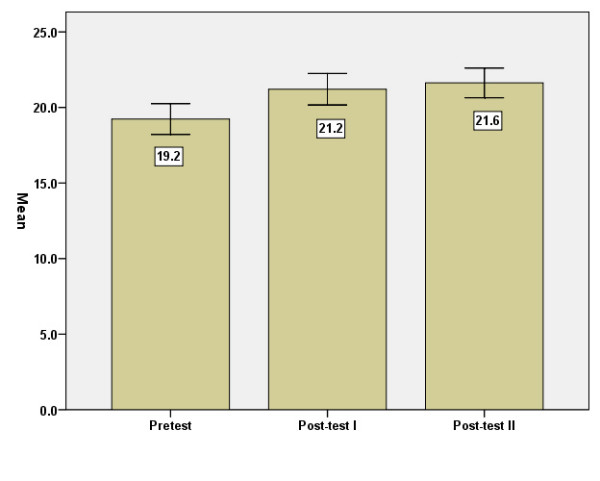
Mastery Scale, means, before = baseline (I), immediately after (II) and three months after (III) the intervention. Error Bars: +/- 1.96 SE.